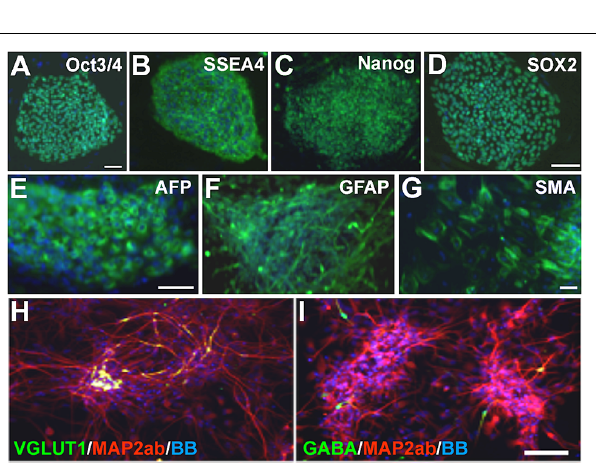
FIGURE 2 | Pretzel Syndrome (PS) induced pluripotent stem cell (iPSC) pluripotency and neuronal differentiation. (A–D) iPSCs obtained from reprogramming PS fibroblasts were immunostained for the pluripotency markers (in green) OCT3/4 (A) , SSEA4 (B) , NANOG (C) and SOX2 (D) . (E–G) Embryoid bodies differentiated from PS iPSCs contained cells from all three germinal layers (green): AFP ( E ; endoderm), GFAP ( F ; ectoderm) and SMA ( G ; mesoderm). (H,I) Neuronal differentiation of PS iPSCs yields mostly microtubule-associated protein 2ab (MAP2ab)/vesicular glutamate transporter type 1 (VGLUT1) double-labeled (H) or MAP2ab-positive and gamma-aminobutyric acid-negative (I) mature excitatory and rare GABA+ inhibitory cortical-like neurons. Bisbenzimide nuclear stain is in blue in all panels. Scale bars: 100 µ m in (A) for (A–C) and (G) ; 75 µ m in (D) , in (E)